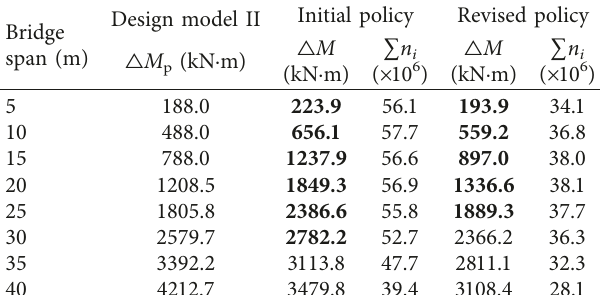
Figure 8: Bending moment amplitude versus the number of stress cycles for a 20m bridge and traffic loading under the initial toll-by- weight policy. Table 11: Equivalent bending moment amplitudes determined using D60 Model II [26] and this study’s methods under the initial and revised toll-by-weight